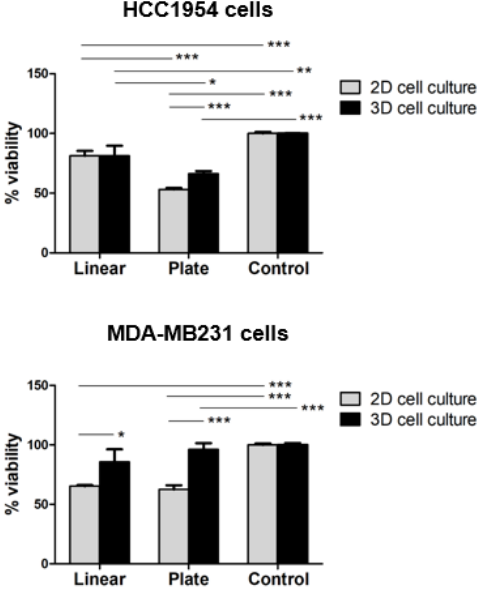
Figure 6. Viability of HCC1954 and MDA-MB231 2D and 3D cell culture after three days post-GET using linear or plate electrodes. Percentage (%) viability obtained using PrestoBlue TM Cell Viability assay. Control: untreated cells. Graphs represent quadruplicate biological repeats analyzed blindly and are displayed as Mean ± SD. Statistical analysis was performed using the Student’s t -test. * p < 0.01, ** p < 0.001, *** p < 0.0001.